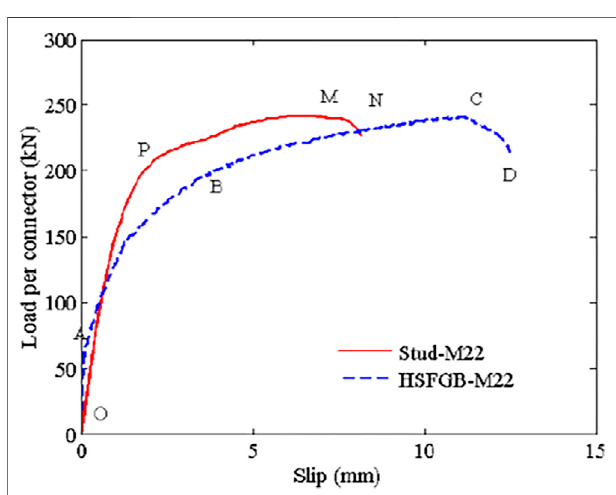
FIGURE 7 | Comparison of the shear performance of different shear